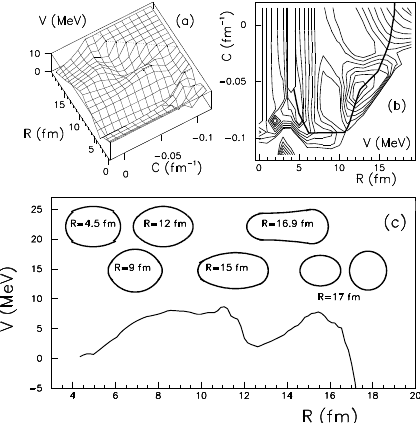
Fig. 2. (a) Minimal values of the deformation energy in MeV as function of the necking coordinate C and the elongation R for 236 Np. (b) Contours of the deformation energy in step of 1 MeV. The least action trajectory is superimposed. (c) Potential barrier. Some shapes obtained during the fission process together with the values of the elongation R are inserted.